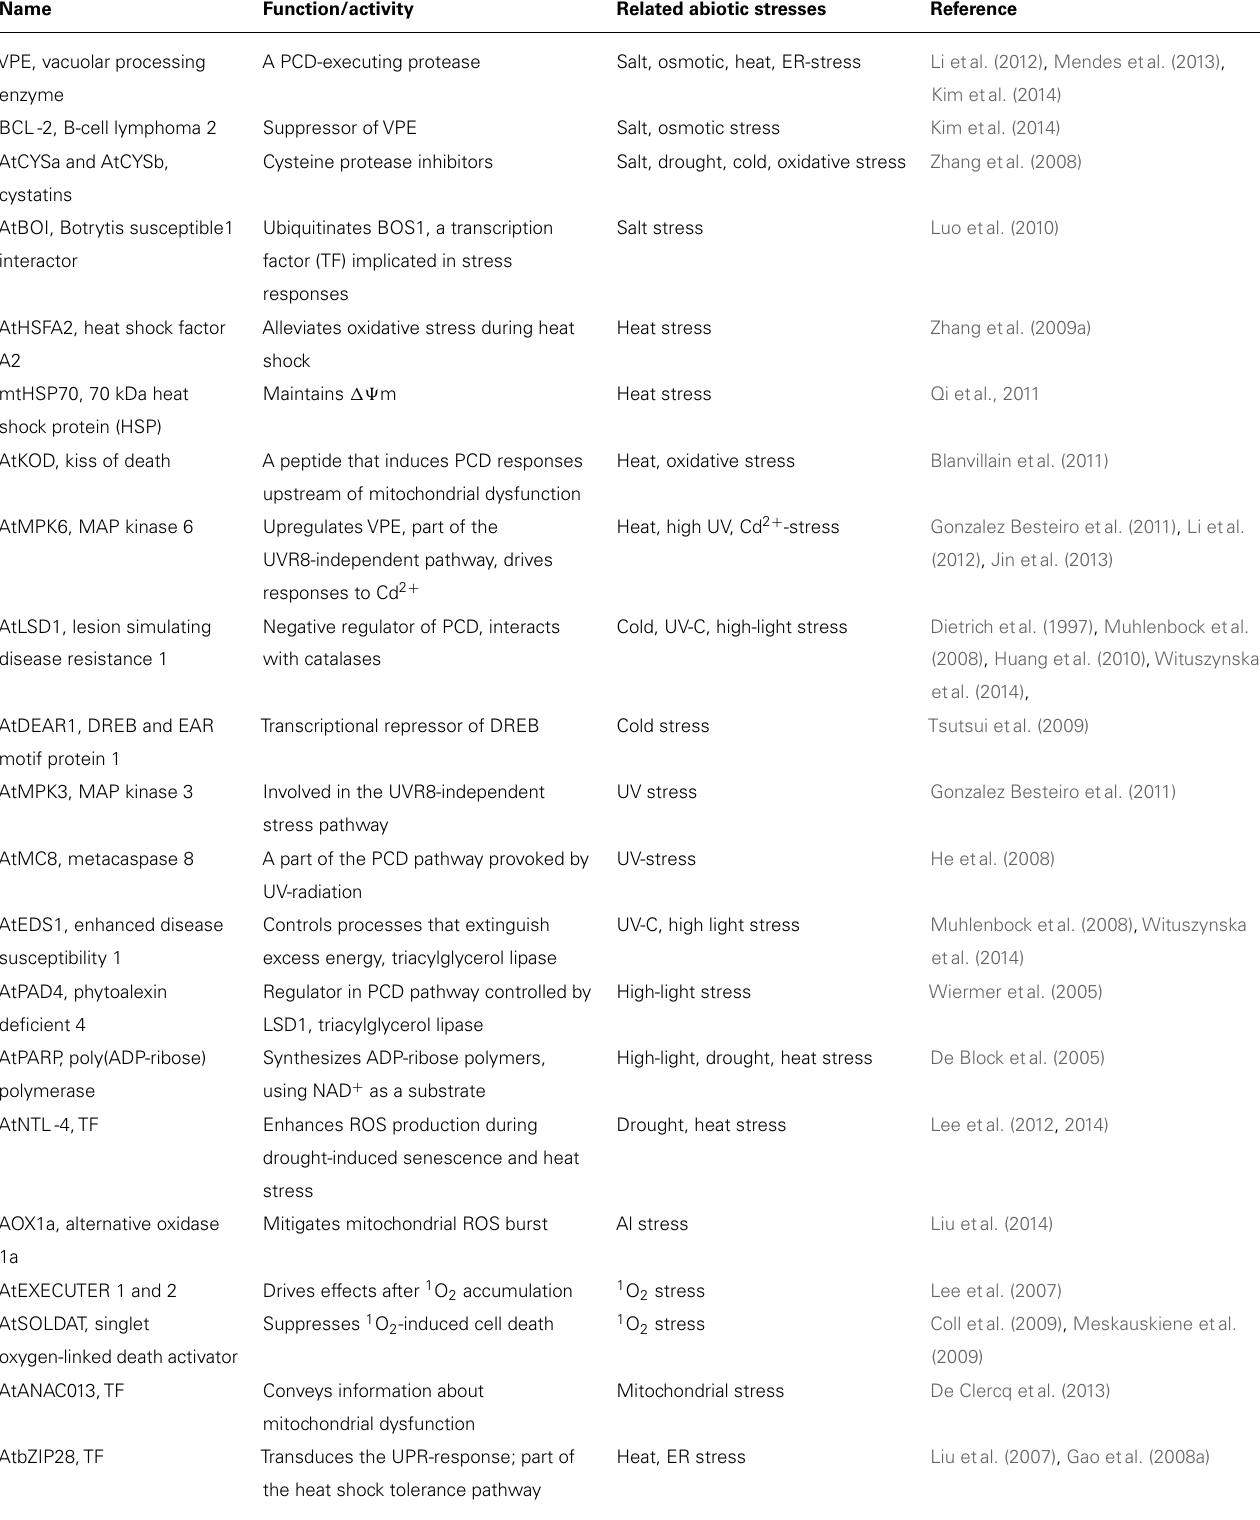
Table 1 | Proteins that participate in the control of PCD processes provoked by different abiotic